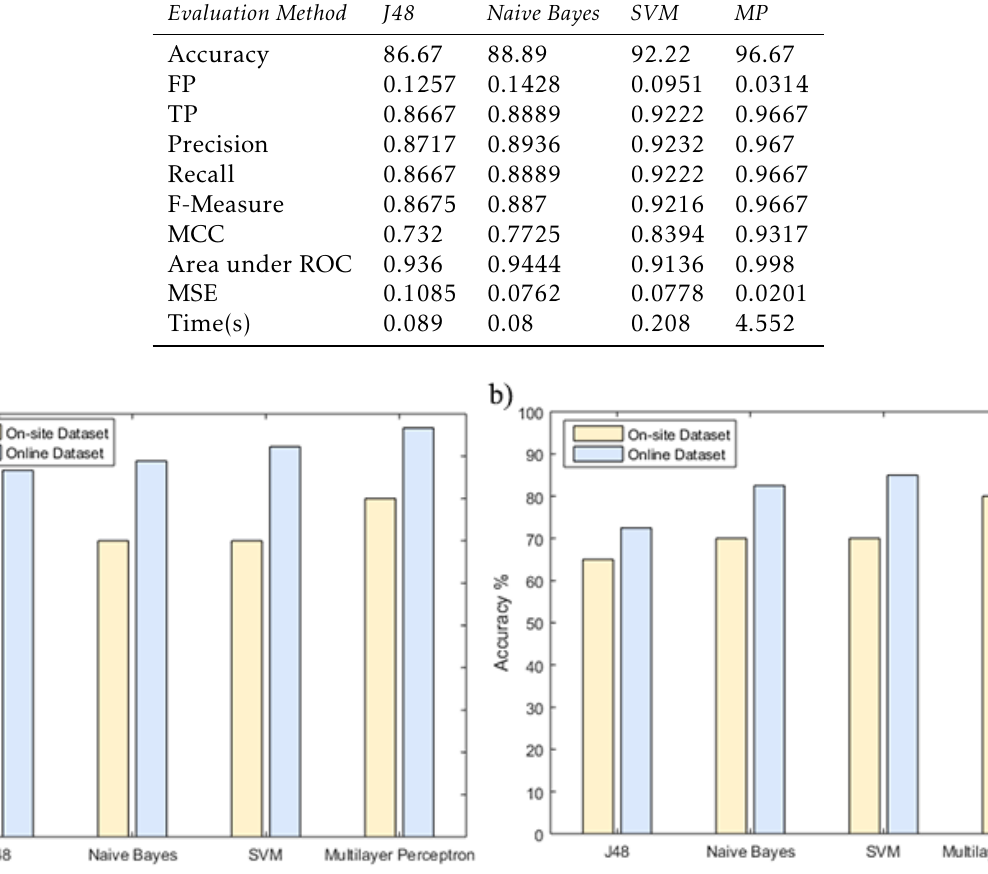
Figure 9. (a) Accuracy comparison of four machine learning models using on-site dataset and online dataset with 90 instances. (b) Accuracy comparison of four machine learning models using on-site dataset and online dataset with 40